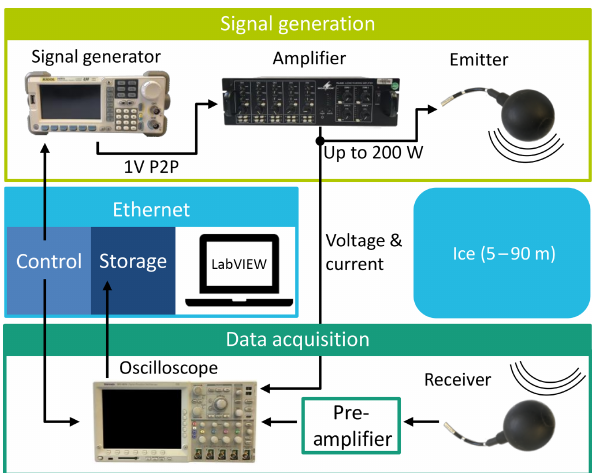
Table 2. Measurement runs. Ave and Rep are the number of aver- ages and repetitions, respectively.